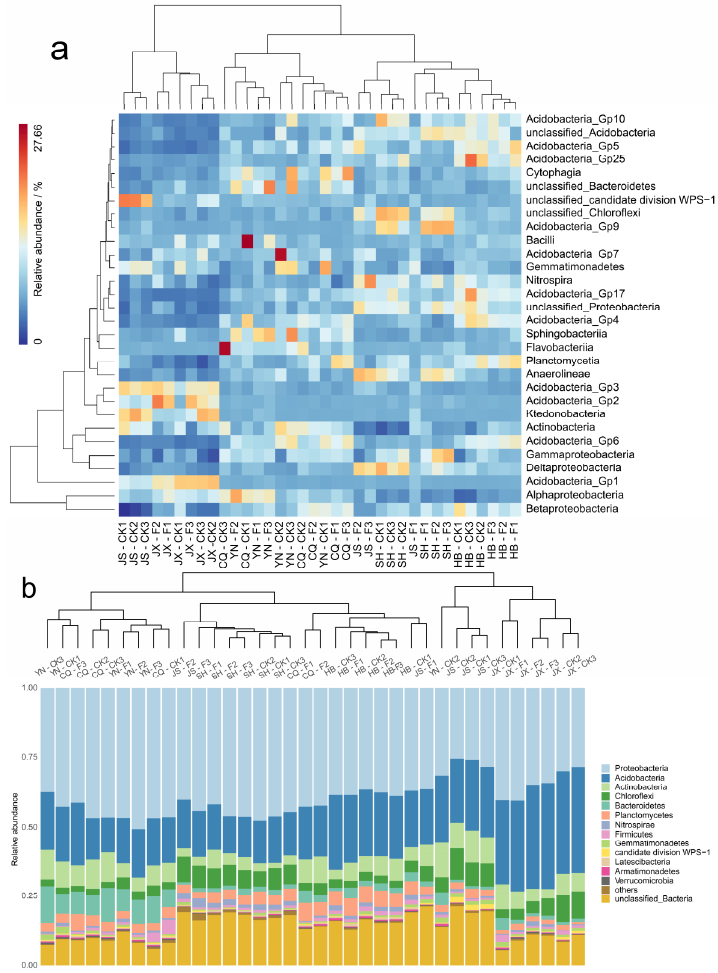
Figure 4. Cluster analysis and relative abundance of bacterial class ( a ) phylum ( b ) based on Bray-Curtis similarities in forested and non-forested soils. JX = Jiangxi; JS = Jiangsu; HB = Hubei; CQ = Chongqing; YN = Yunnan; SH = Shanghai; CK = non-forested soils; F = forested soils. Arabic numbers of 1, 2 and 3 after abbreviations indicated soil depth at 0–15, 15–30 and 30–45 cm, respectively.